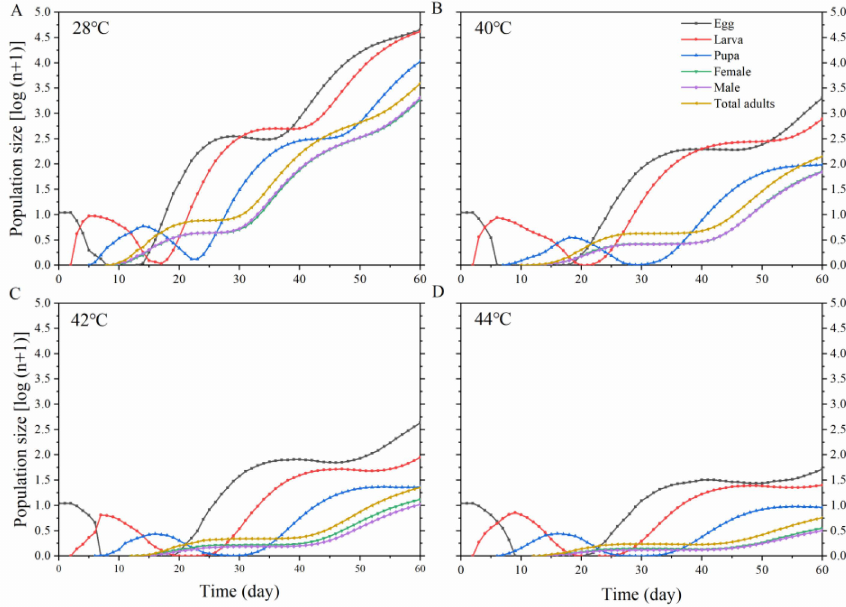
Figure 6. Projection of Ophraella communa population growth reared under different temperatures considering an initial population of 10 eggs. ( A ): 28 ◦ C, ( B ): 40 ◦ C, ( C ): 42 ◦ C, ( D ): 44 ◦ C.